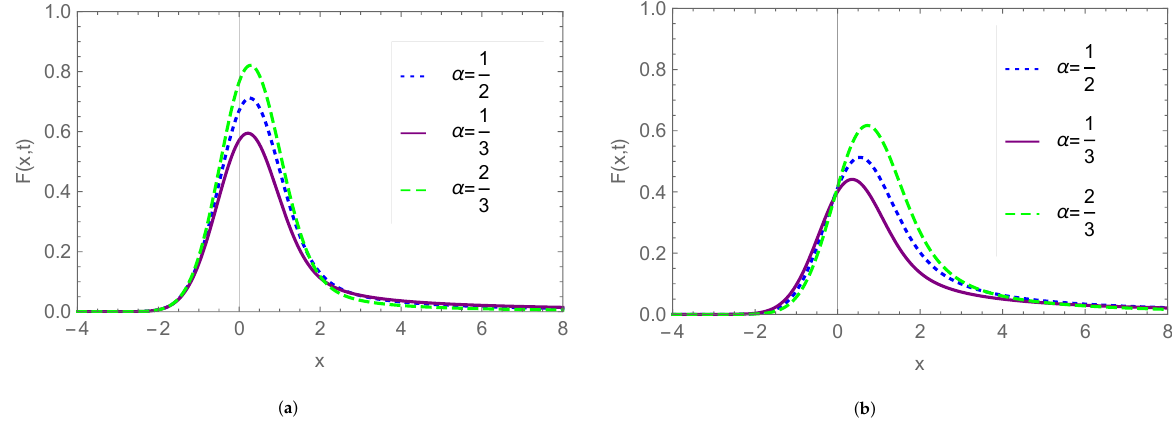
Figure 3. Comparison between the solutions of Equation (17) for different values of α and t . ( a ) t = 0.5; ( b ) t = 1.